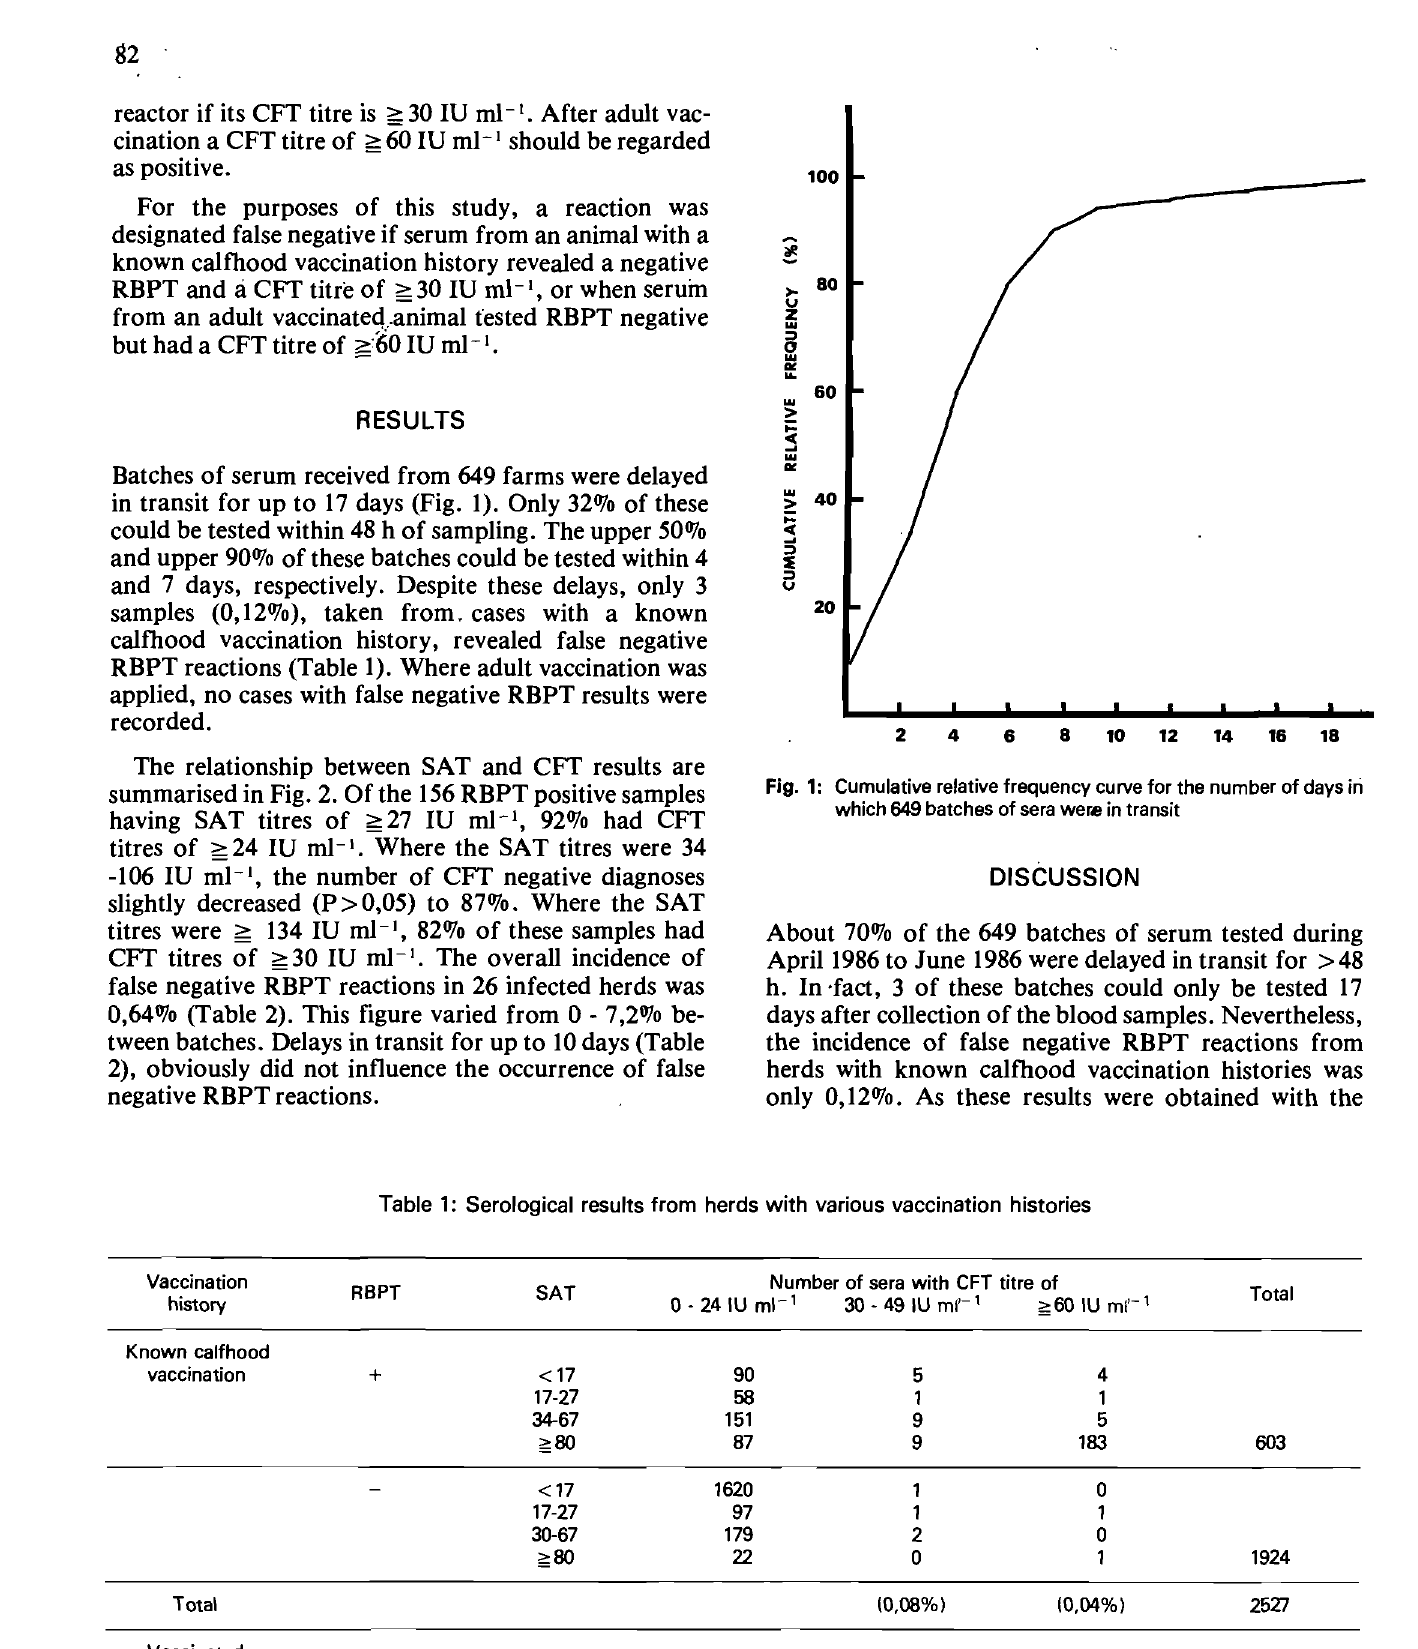
Table 1: Serological results from herds with various vaccination